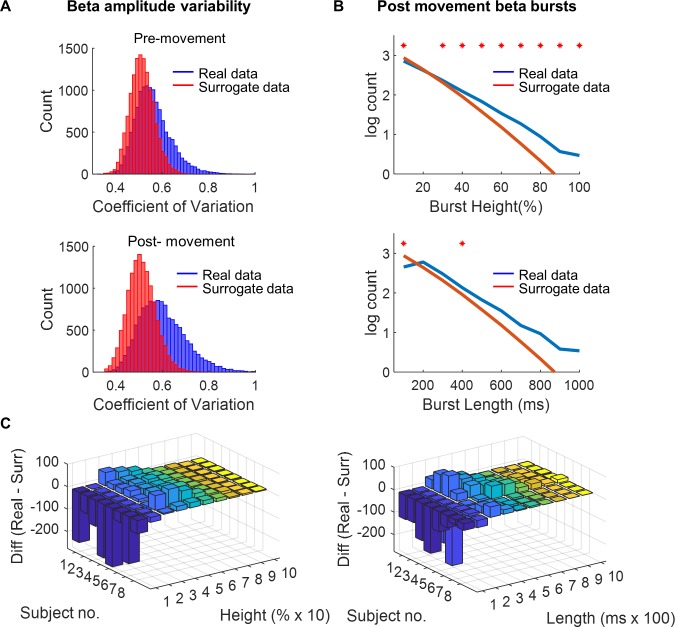
Comparison of movement-related beta amplitude changes and phase-randomised surrogate data.(A) Beta amplitude variability is quantified by the CV of beta amplitude for pre- and post-movement periods, respectively. The CV in the observed data is significantly larger (right shift in histogram) in both the pre- and post-movement periods when compared with a spectrally matched surrogate dataset. (B) Group-level line histogram of the log10 mean burst counts for different heights (B: top) and lengths (B: bottom) for real versus surrogate post-movement data (*p < 0.05, false discovery rate [FDR] corrected). (C) Difference in burst height and length counts shown for each subject compared with bursts from a surrogate phase-randomised dataset (burst height/length real data minus burst height/length surrogate data). This demonstrates a relative reduction in the number of the smallest and shortest bursts in the real compared with surrogate data, with an increase in larger and mid-length bursts (same analysis shown for pre-movement data in S2 Fig). The underlying data can be found at https://osf.io/eu6nx/. CV, coefficient of variation.